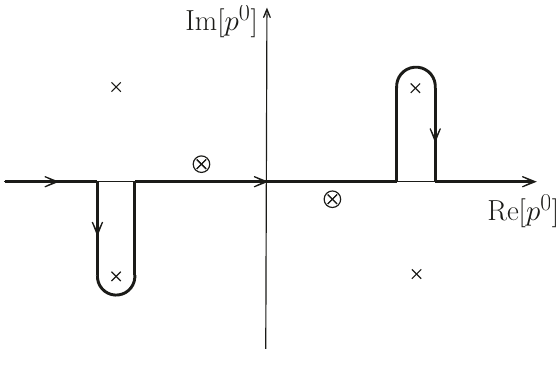
Figure 2 . The Lee-Wick integration